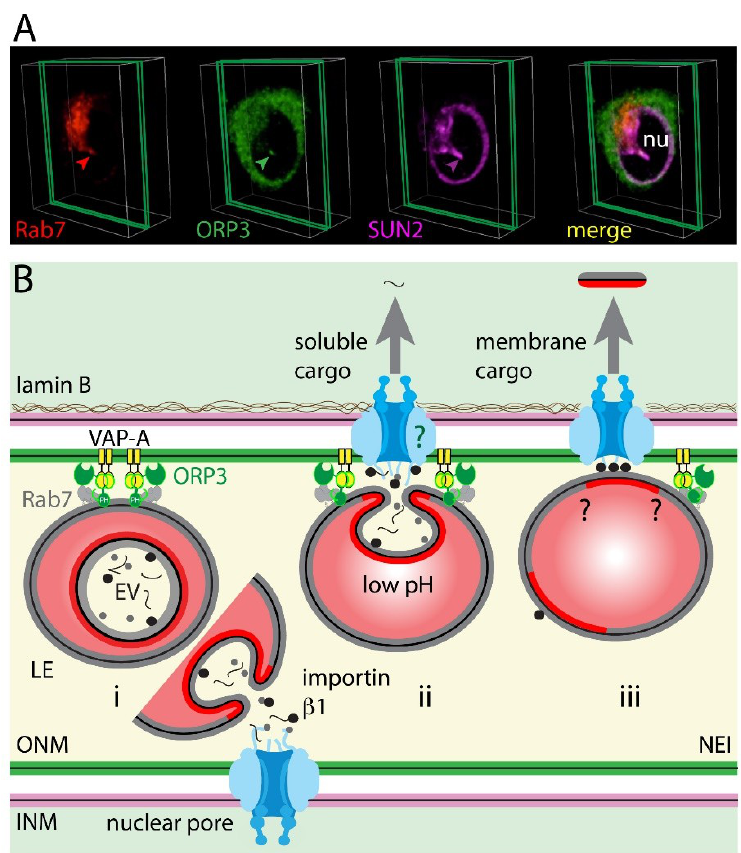
Figure 3. VOR complex is involved in the translocation of late endosomes into the nucleoplasmic reticulum and nuclear transfer of EV-derived components. ( A ) ORP3, a member of the VOR complex, is associated with nuclear envelope invagination (NEI). Melanoma FEMX-I cells expressing Rab7-red fluorescent protein were double immunolabeled for ORP3 and SUN2 as described [160]. 3D reconstruction of three optical sections (green slice) of a given cell is shown. The protein of interest within NEI is indicated (arrowhead). Nu, nucleoplasm. ( B ) Schema summarizing the players of VOR complex and their interactions within NEI. In this model, a late endosome containing endocytosed EVs (EV) is transported to NEI and tethered to outer nuclear membrane (ONM) (i). The latter process is mediated by the type II transmembrane, endoplasmic reticulum (ER) / ONM-associated VAP-A protein (yellow), cholesterol-sensor ORP3 protein (green) that binds to VAP-A via its FFAT motif, and late endosome-associated Rab7 (gray). The pleckstrin homology (PH) domain of ORP3 might mediate its binding to late endosomal membrane. The inhibition of transfer of EV-derived components (soluble and membranous) into the nucleoplasm of host cells after importazole treatment suggests that importin α 1 / β 1 (may be those associated with EV; black spot) and nuclear pores play a role in these processes (ii). The potential interaction of nuclear pore components with VOR complex should be addressed in a near future (green question mark). Other urgent questions remain open, notably the mechanism(s) allowing the extraction of EV-derived membrane proteins (red) from endosomal membrane and their transfer into nucleoplasm through the nuclear pores, which are size restricted (iii, black question mark). The low pH milieu in late endosome might favor the fusion of endocytosed EVs with its membrane (i–iii). [Fluorescence images were originally published in the Journal of Biological Chemistry: Santos MF, Rappa G, Karbanov á J, et al. VAMP-associated protein-A and oxysterol-binding protein-related protein 3 promote the entry of late endosomes into the nucleoplasmic reticulum. 2018; 293:13834–13848 [160]. © The American Society for Biochemistry and Molecular